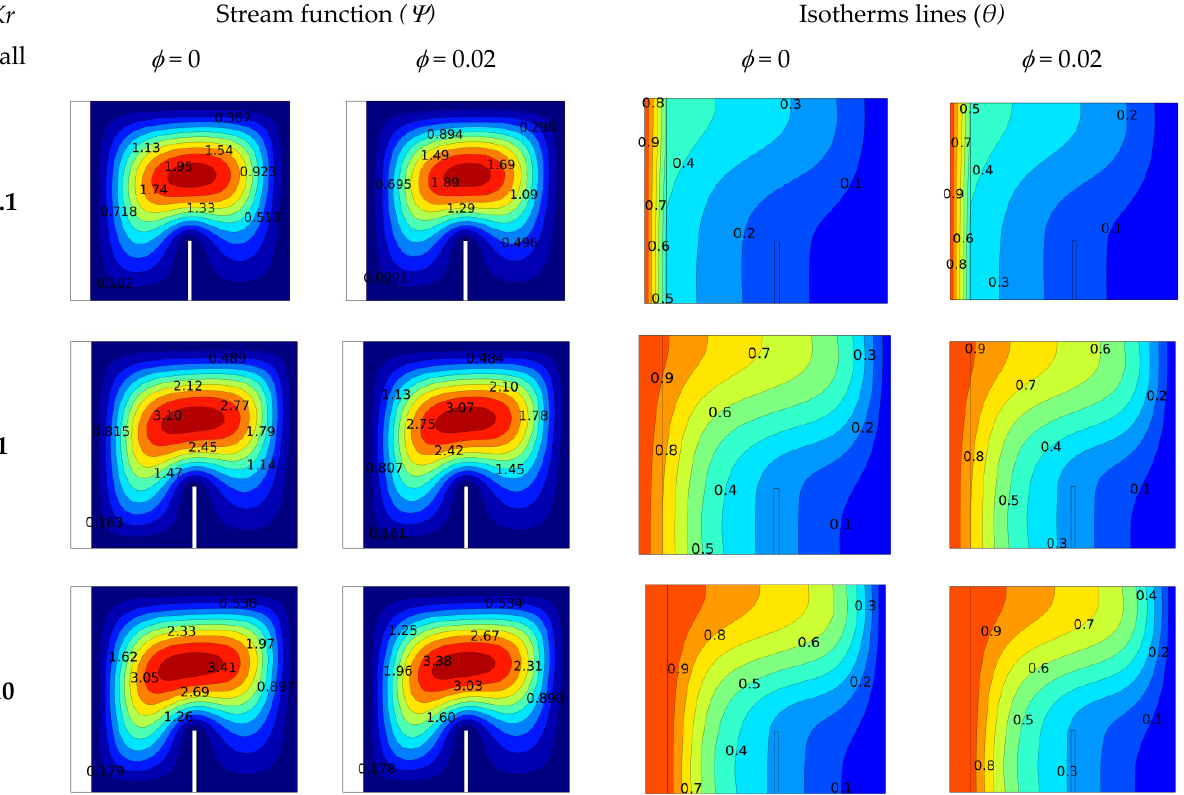
Figure 9. Effect of the hot thick wall on streamlines (two left columns) and isothermal patterns (two right columns) for different value of solid volume fraction at 𝑅𝑎 = 10 4 and = 90.